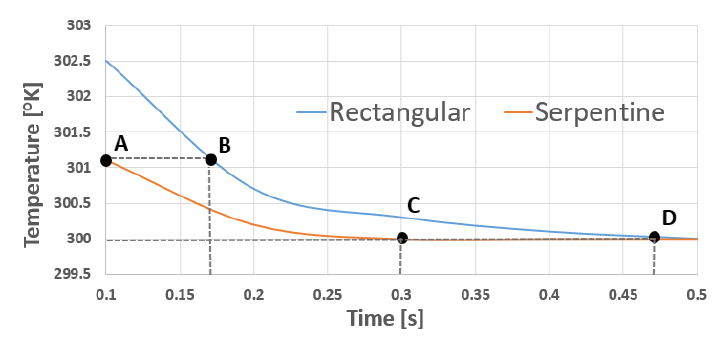
Figure 3. Temperature vs. Time for different shapes: rectangular and serpentine.